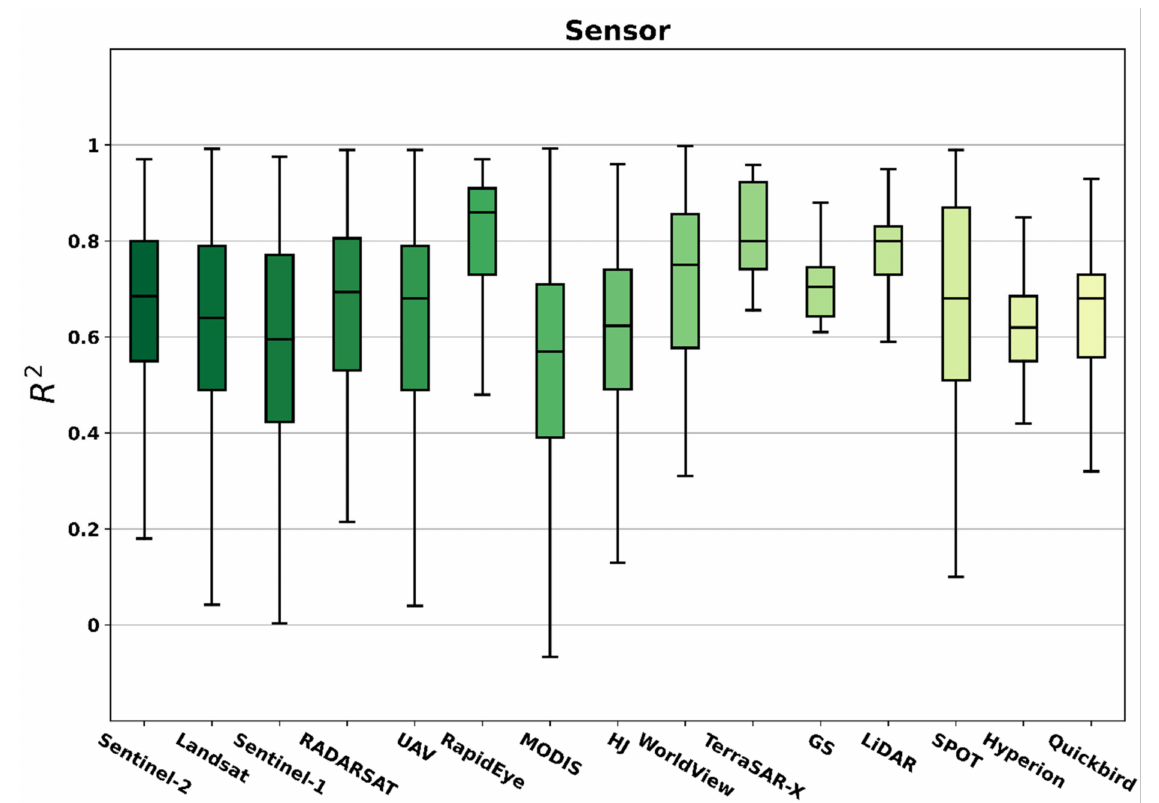
Figure 21. The coefficient of determination (R 2 ) of specific